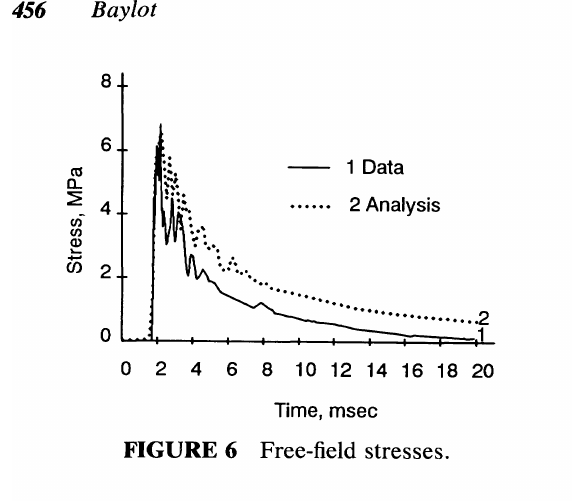
FIGURE 6 Free-field stresses.